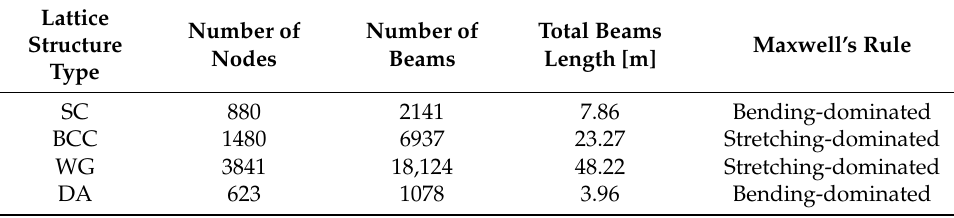
Table 3. Geometric information of the wireframes and Maxwell law results.